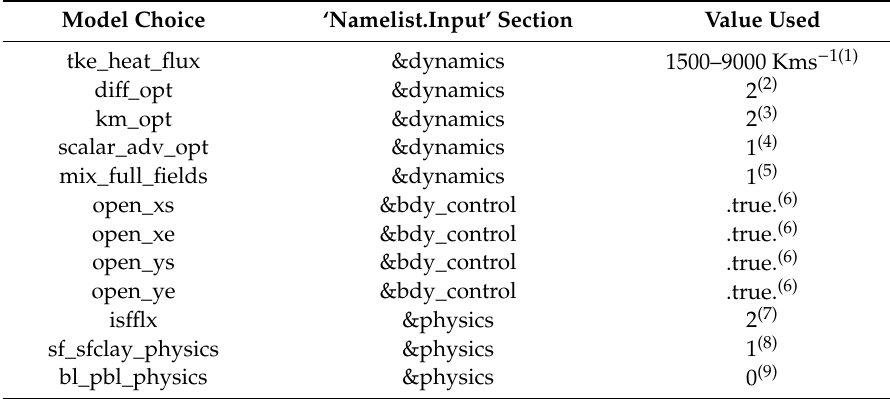
Table A1. The principal model choices, and their significance, used in this